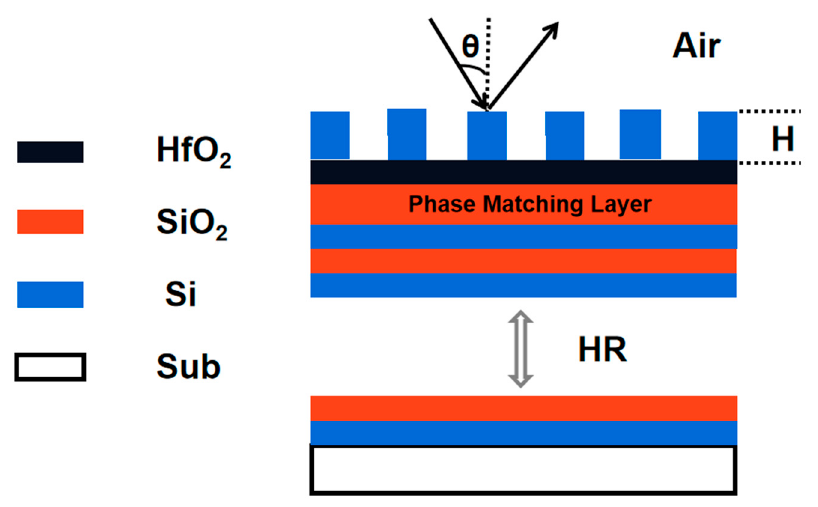
Figure 3. Brief structure demonstrating the pure silicon grating for comparation. The grating consists only of silicon material. Table 5. Parameter of reflective grating to determine the phase match layer of SiO 2 .